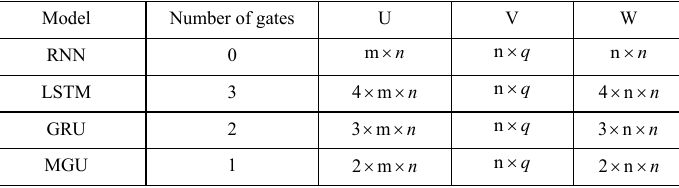
Table 1. The parametric scale of recurrent neural networks.